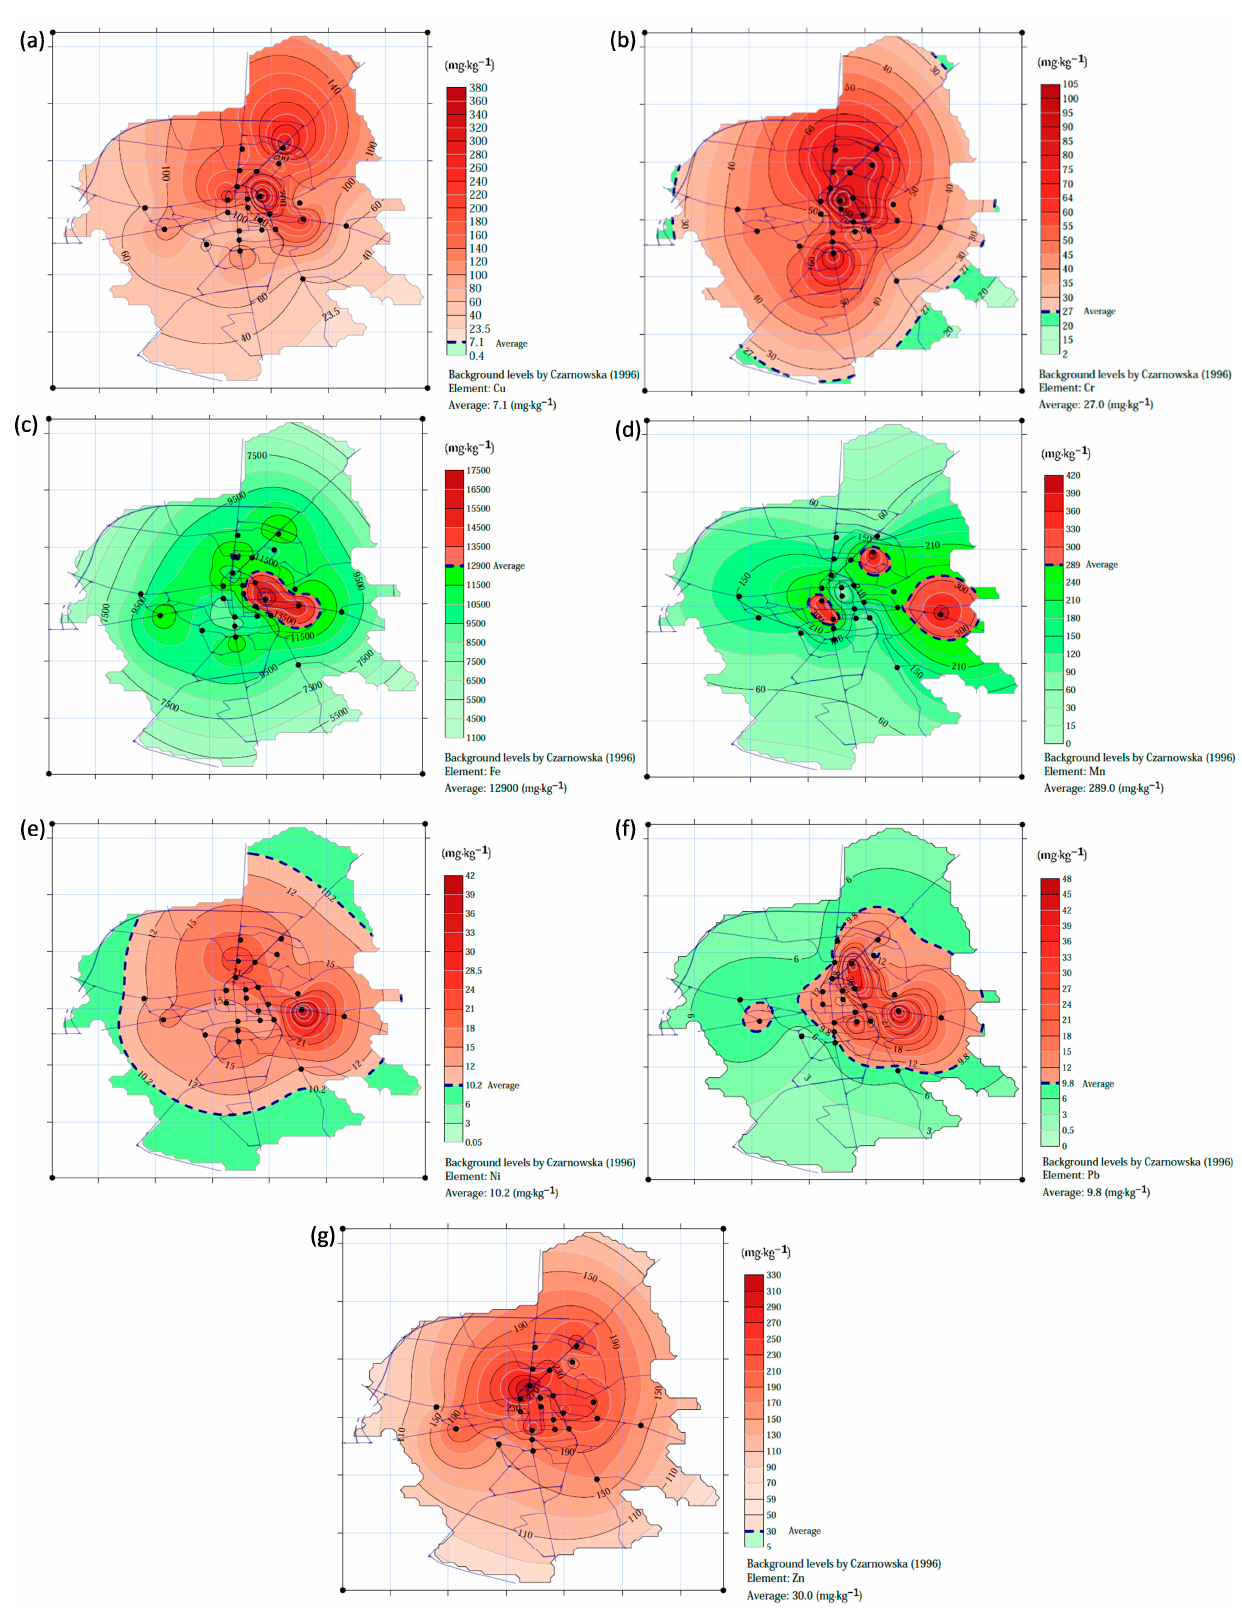
Figure 5. Spatial distribution of heavy metals in road dust in Suwałki: ( a ) Cu, ( b ) Cr, ( c ) Fe, ( d ) Mn, ( e ) Ni, ( f ) Pb, ( g ) Zn